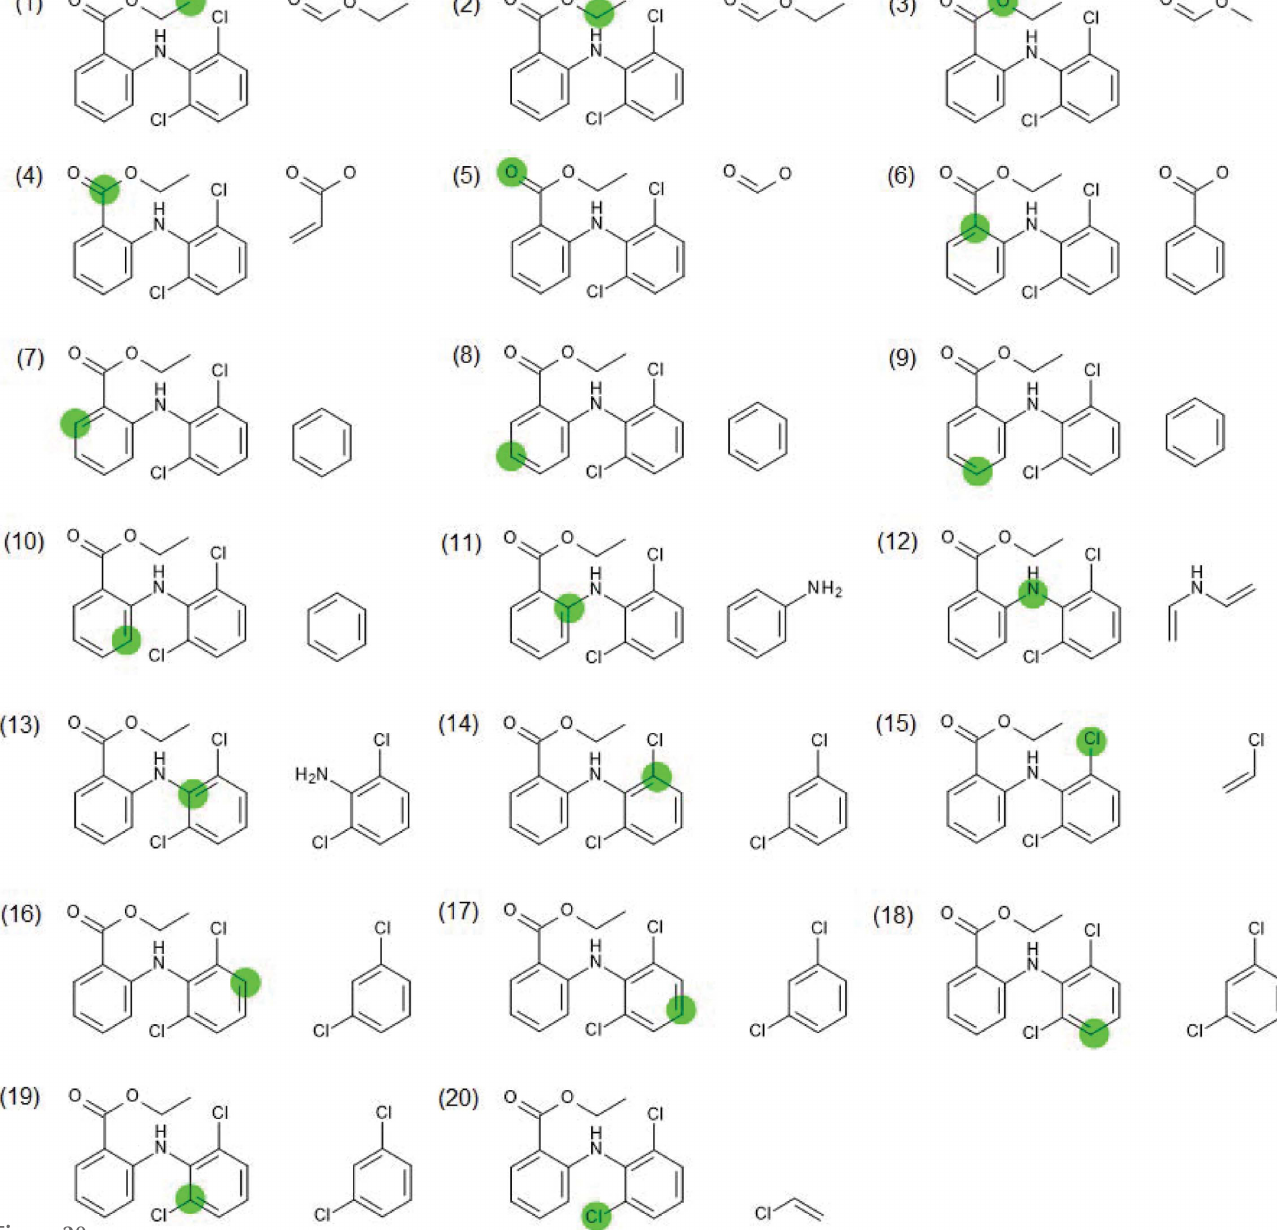
Figure 20 Fragments for each non-hydrogen atom in